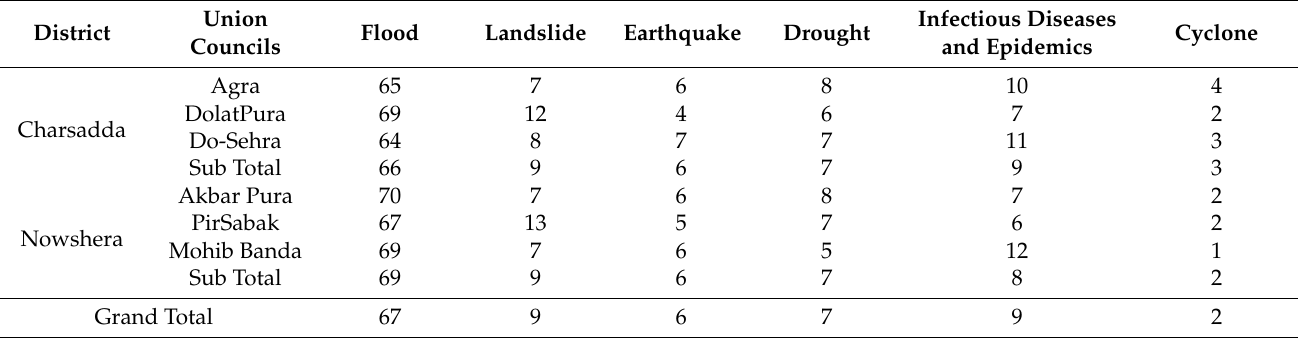
Table 3. Major risks experienced by the local